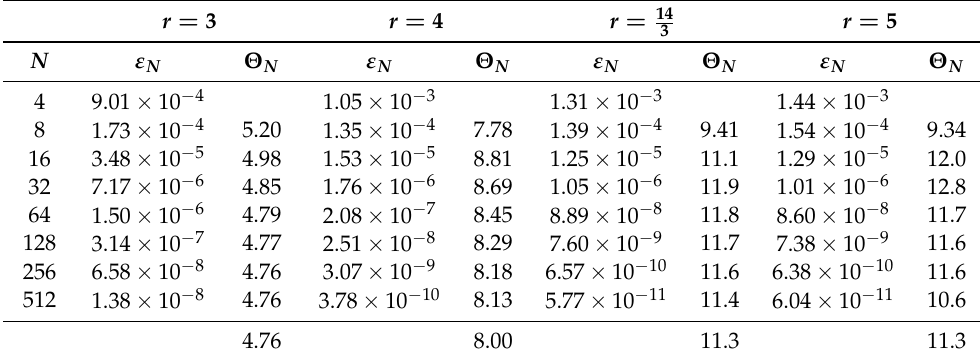
Table 2. Numerical results for problem (65) and (66) with m = 3. r =